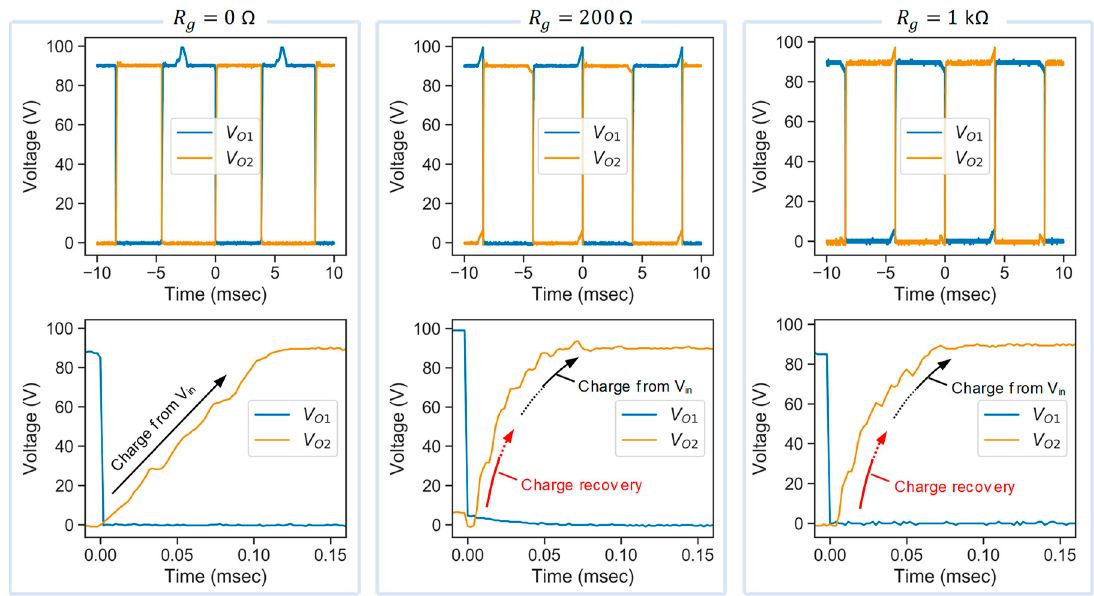
Figure 12. Voltage waveform with load of flapping wing piezoelectric actuator with different 𝑅 𝑔 .